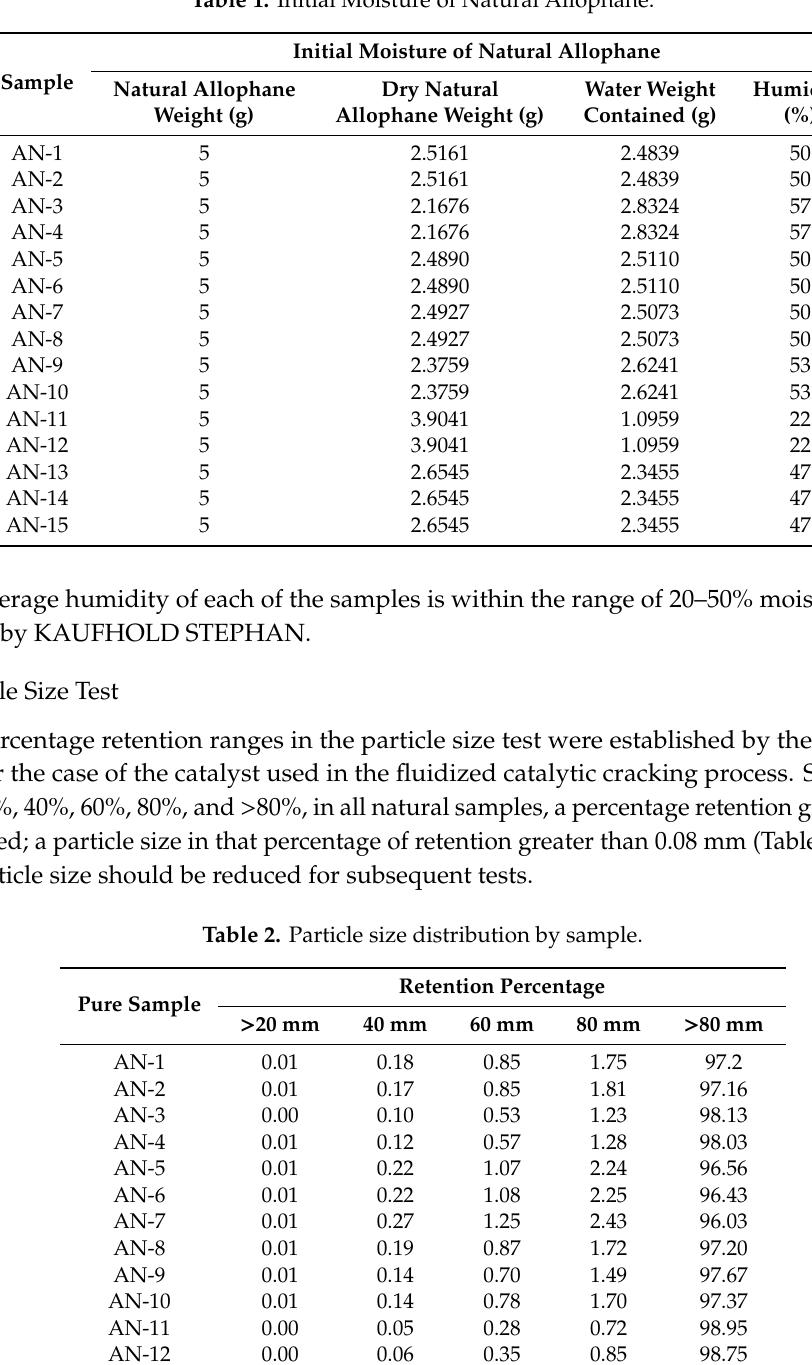
Table 1. Initial Moisture of Natural Allophane.